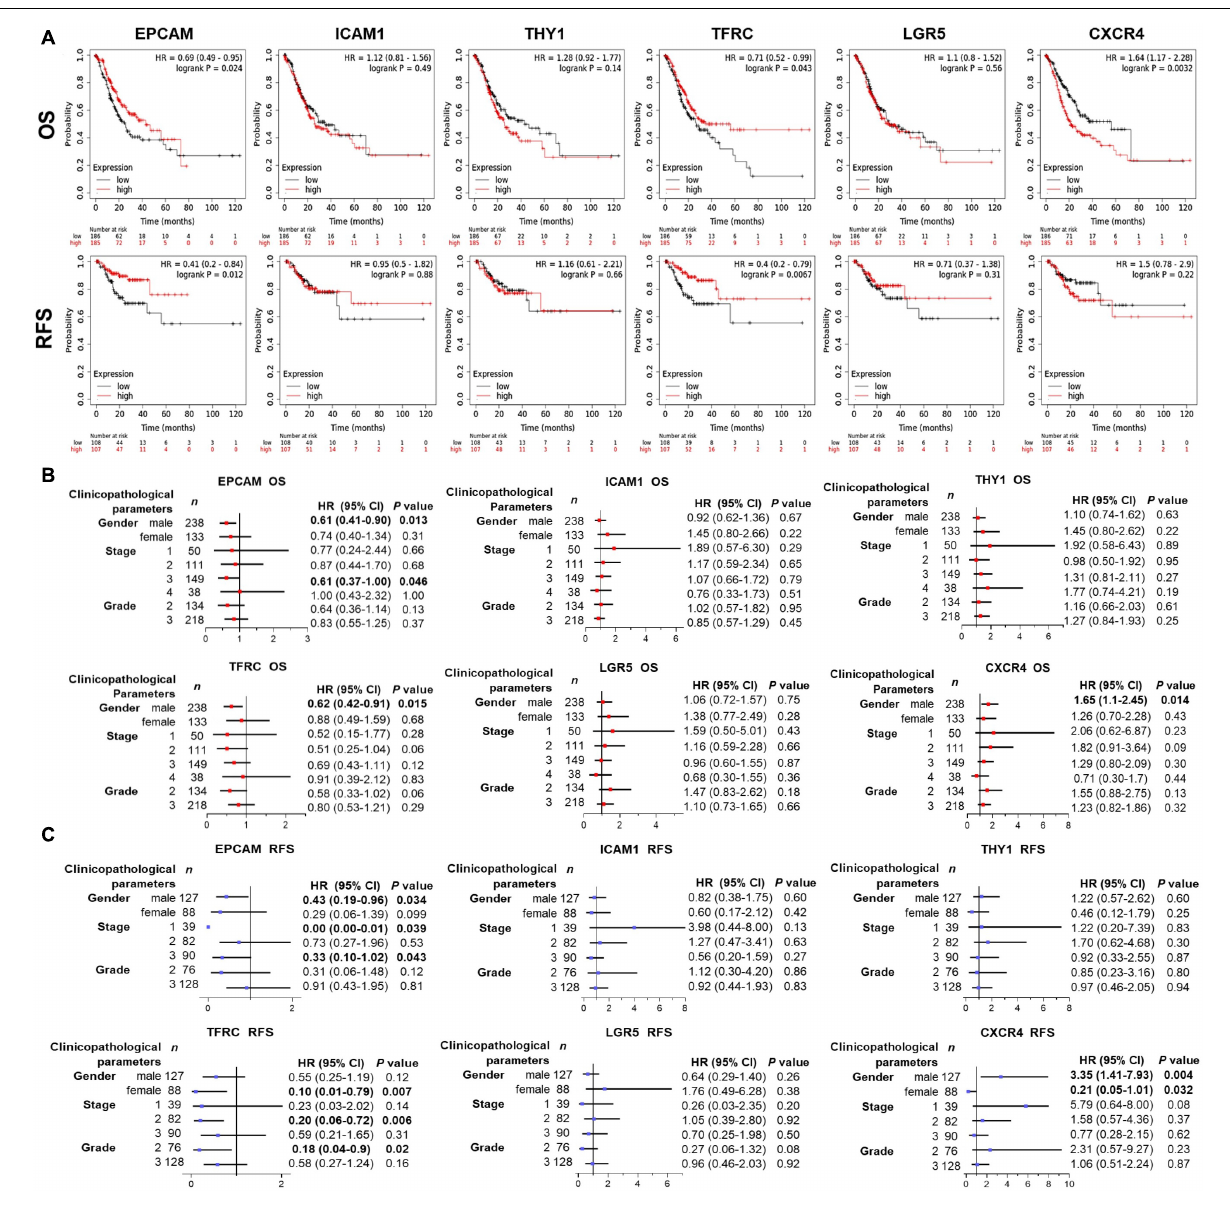
FIGURE 4 | Prognostic significance of GCSC markers in GC patients (KM Plotter). (A) The survival curves show the associations between the expression of GCSC markers with OS and RFS of all GC patients. Forest plots show the associations between the expression of GCSC markers with (B) OS and (C) RFS of GC patients with different clinicopathological parameters. P- values with statistical significance are in bold. OS, overall survival; RFS, relapse free survival; HR, hazard ratio; CI, confidence